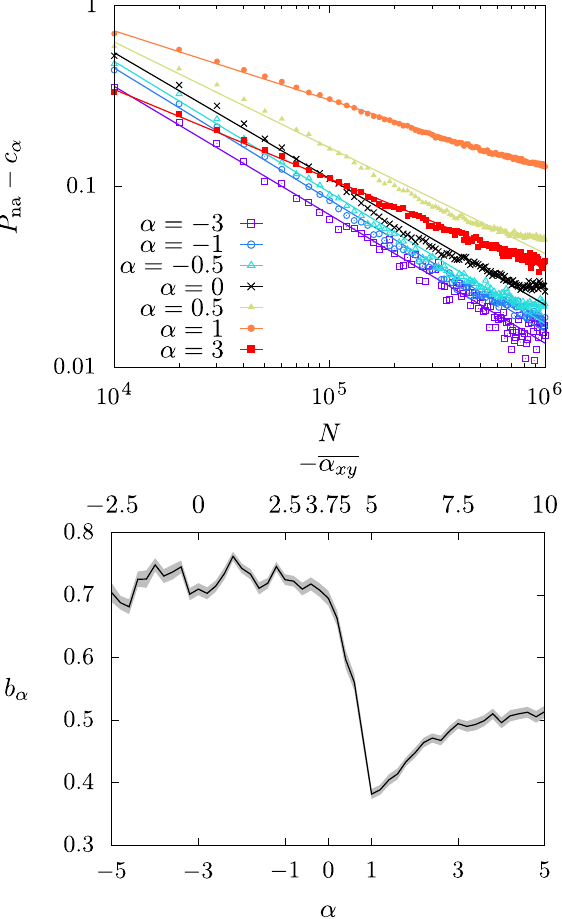
FIG. 8. Top: log-log scale representation of the data of the bottom-right plot of Fig. 7, having subtracted the offset c α from P . The fit lines are also shown. Bottom: Values of the parameter na b P N Þ ¼ a N − b α þ c α of the model α α that fits the data of the na ð bottom-right plot of Fig. 7 as a function of the detuning coefficient α , which is set by varying α xy . The shaded area represents the error attributed to the computation of the fit